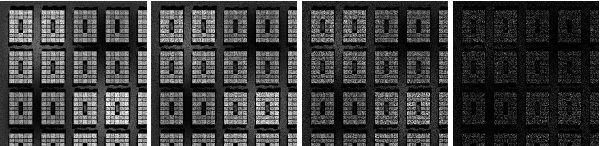
Figure 6: Synthetical DSMs, occluded (elevation 60 ◦ ), increasing hole probability 10 %, 20 %, 40 %, 80 %